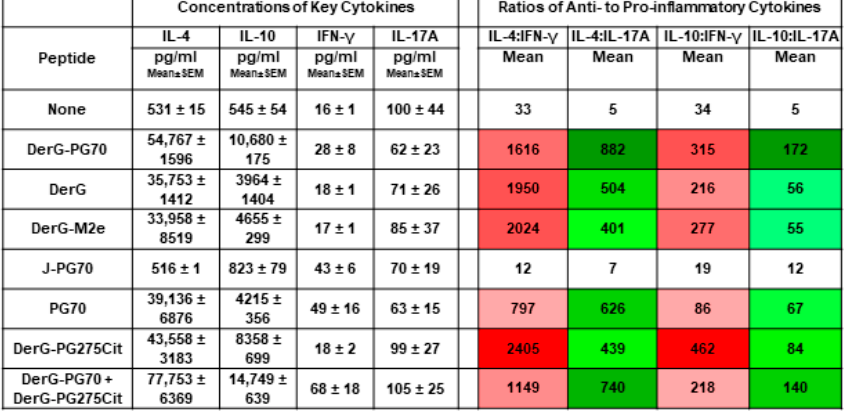
Figure 9. The effects of CEL-4000 and other peptides on the in vitro differentiation of Th2 cells from unvaccinated GIA mice. CD4+ spleen cells isolated from unvaccinated GIA mice were co-cultured with GIA spleen antigen-presenting cells, rhG1, and without (None) or with the indicated peptides in the presence of Th2 differentiation promoting reagents for a 6-day differentiation period, then the reagents were washed out, and the peptides and rhG1 were added back for a 2-day post-differentiation period. Results are expressed as concentrations.